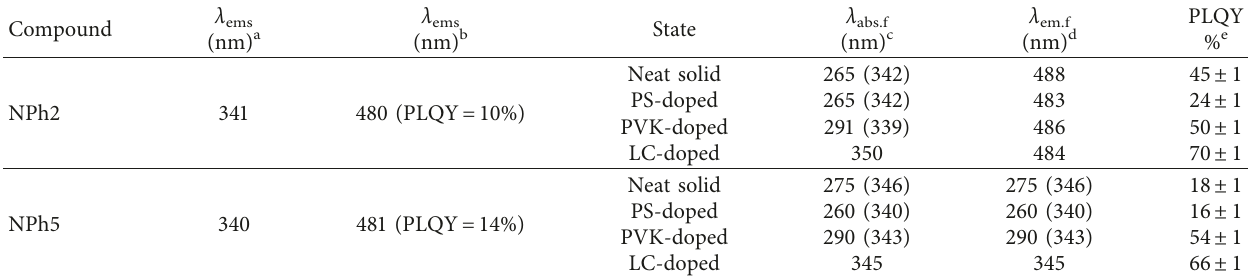
Table 1: Optical data of